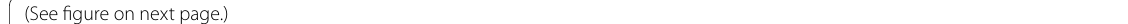
sensors(See figure on next Fig. 6 Raw data recorded by the FOG and seismograph sensors during the a main shock and b aftershock events. Resultant spectra and reconstructed signal waveforms generated in the signal processing Step 1 for the c main shock and d aftershock events. Normalized intensity of the seismic waves recorded by the seismograph and FOG sensors during the e main shock and f aftershock events under the energy conversion law (Eq. (1)). g Median‑filtered main‑shock and h aftershock signals recorded by the seismograph and FOG